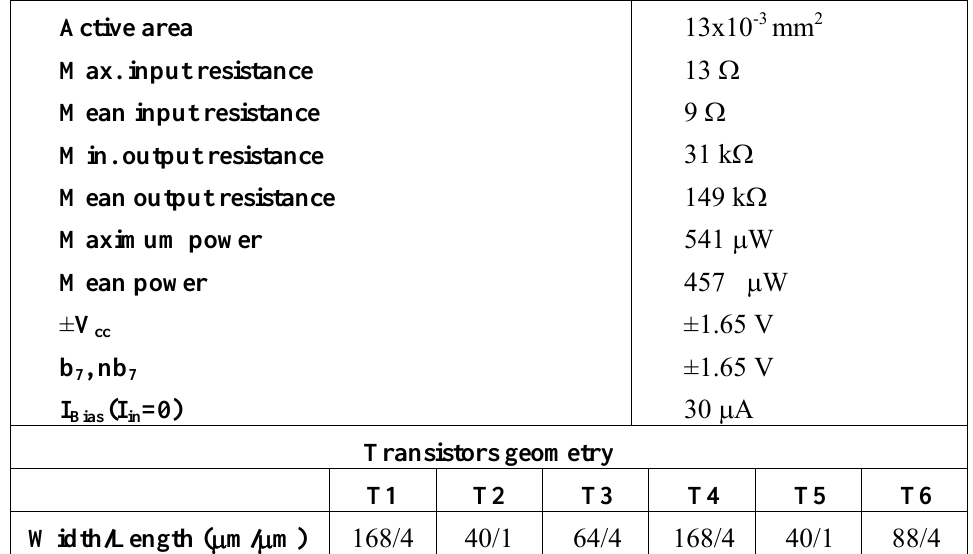
Table 1. Sign circuit Characteristics.